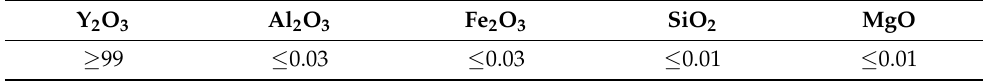
Table 3. Chemical compositions of the white fused alumina powders (mass fraction %). Table 2. Chemical compositions of the Y 2 O 3 powders (mass fraction %).